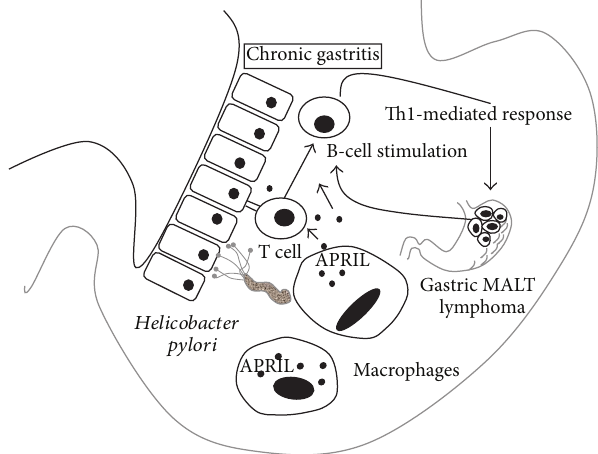
Figure 1: Helicobacter pylori -caused gastritis is crucial in an evolu- tion of gastric MALT lymphoma localized in the stomach. In the gastric mucosal cells, there are elevated levels of some cytokines, including proliferation-inducing ligand (APRIL), the protein with a crucial role in B-cell maturation and survival. APRIL induces alsoB-cellstransformationandthelymphomaprogression.Gastritis attracted macrophages, which, under a Helicobacter pylori infection, release large amounts of